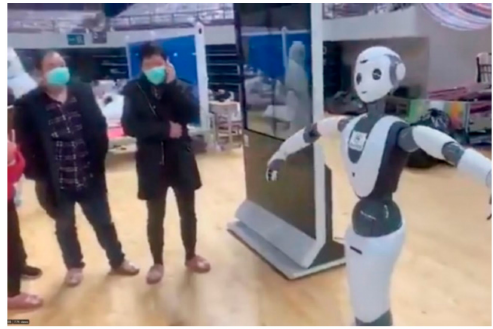
Figure 20. 5G Cloud robots deployed in Chinese hospitals [85]. Table 6. Mapping of COVID-19 management steps using robotic